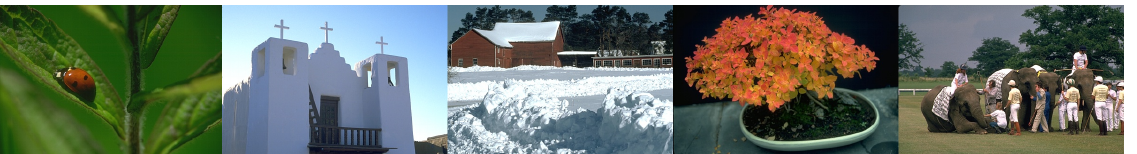
Figure 6. Selected images from the Berkley image segmentation dataset. Image identifiers are: 35058, 24063, 97033, 353013, 361084.